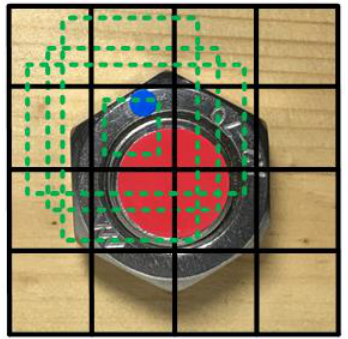
Figure 7. Prior boxes in a feature image.